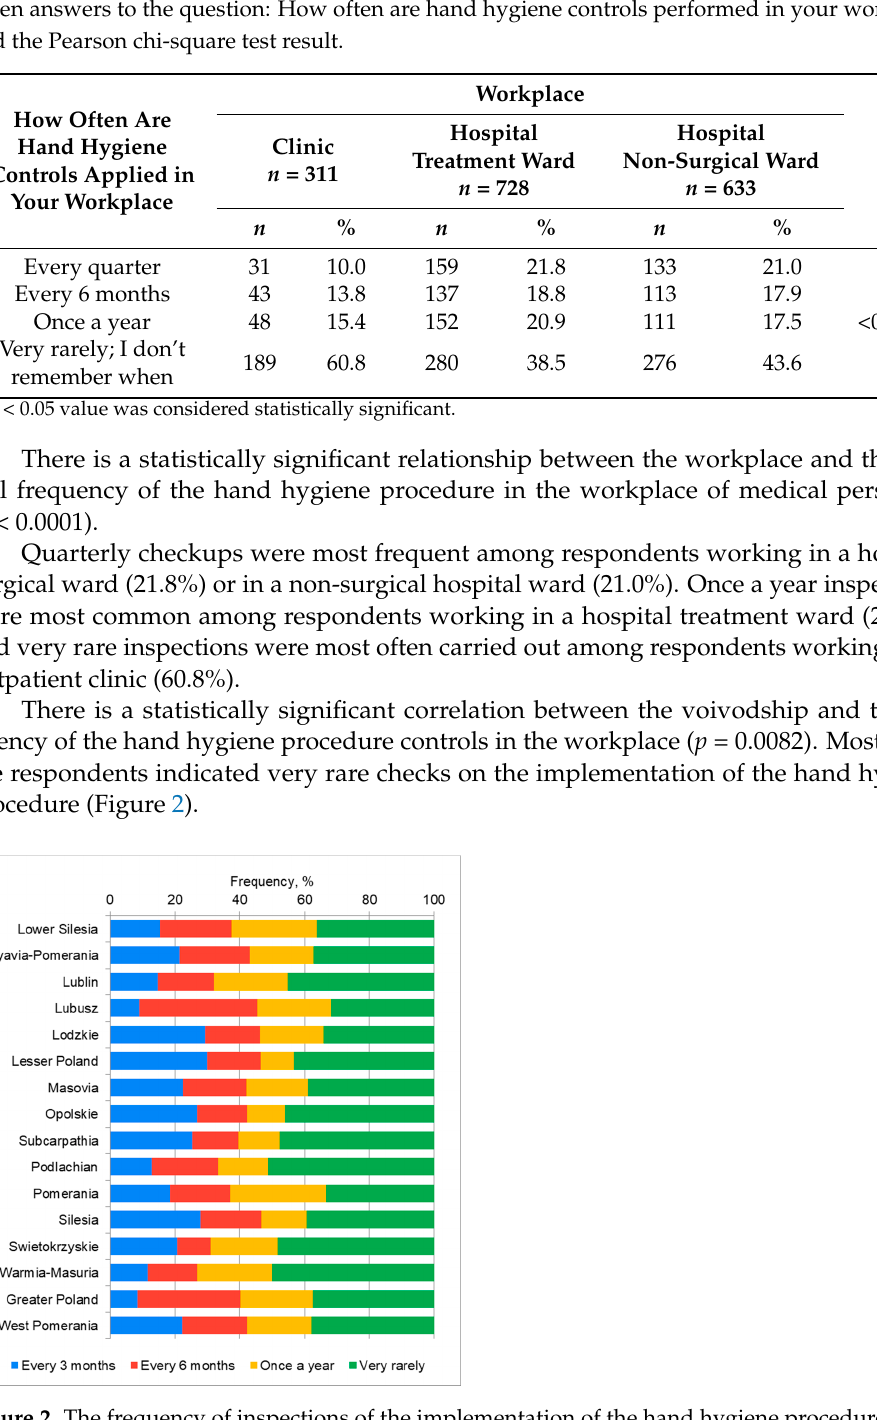
Table 3. Number ( n ) and frequency (%) of the respondents from different workplaces according to the